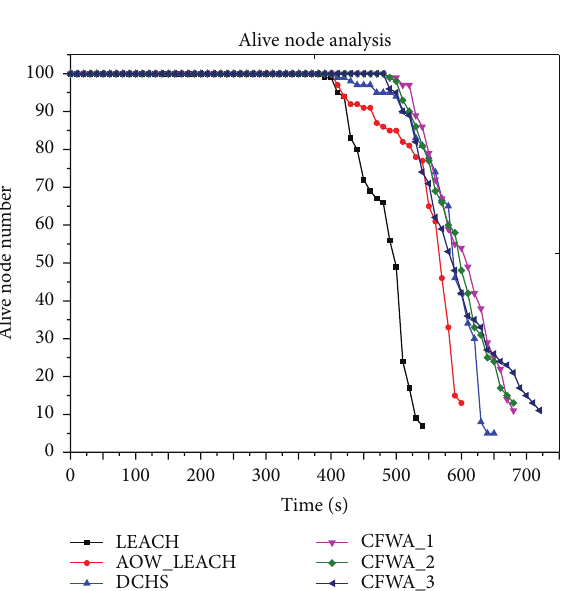
Figure 5: Alive nodes comparison diagram between CFWA family algorithms and LEACH-like algorithms in 100